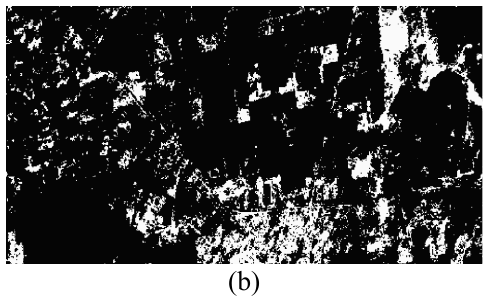
Figure 3: Rejection of null hypothesis based on various significance levels (a) 1% (b) 5%